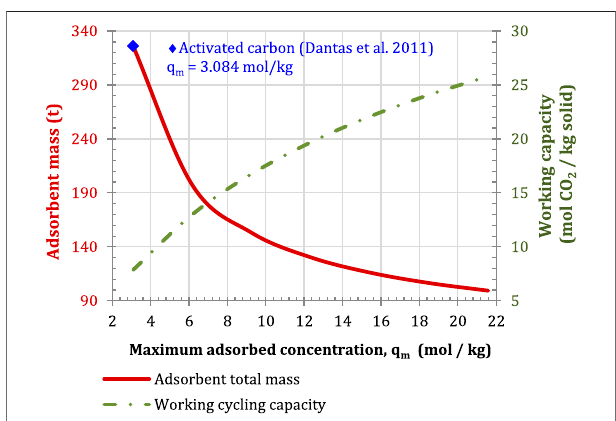
FIGURE 10 | Sensitivity of adsorbent mass and working capacity to the maximum adsorbed. Con fi guration parallel S-EGR at 70% recirculation